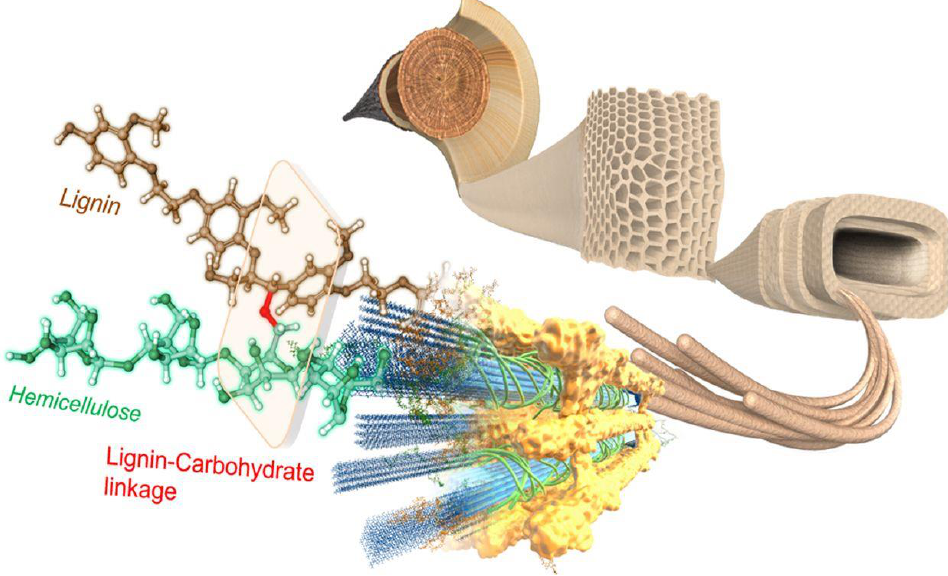
Figure 2. Graphical illustration of lignin, cellulose, and hemicellulose in the plant cell (adapted from [27]).